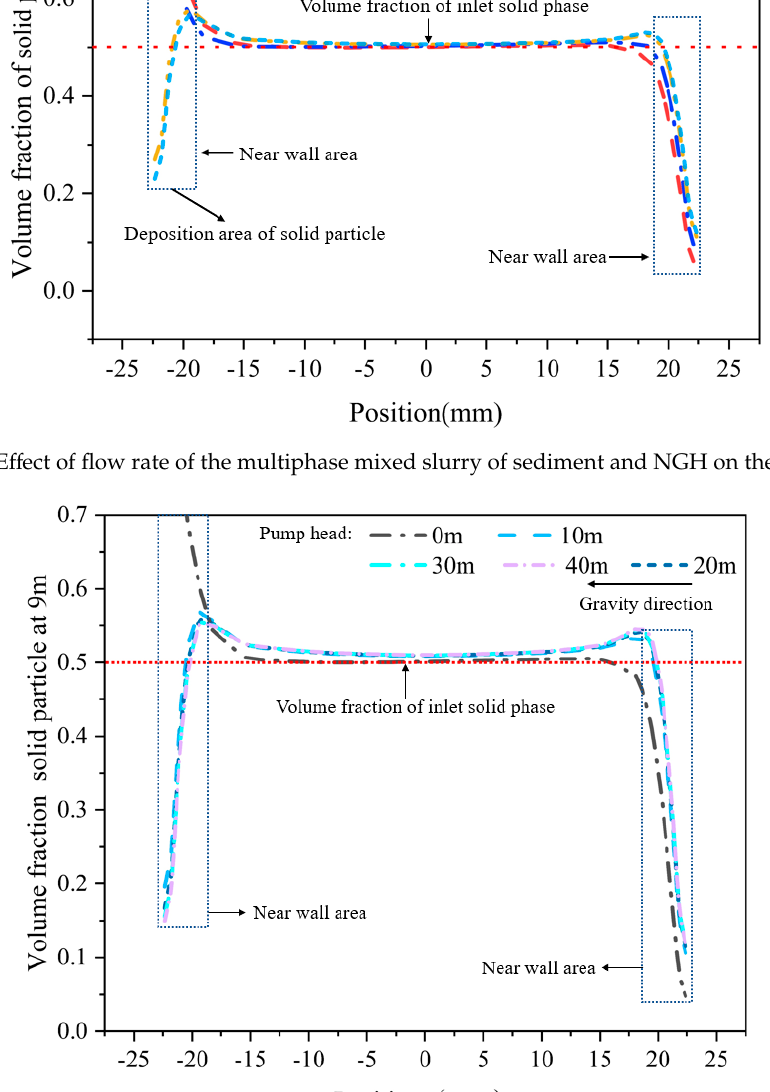
Figure 10. Effect of flow rate of the multiphase mixed slurry of sediment and NGH on the migration.